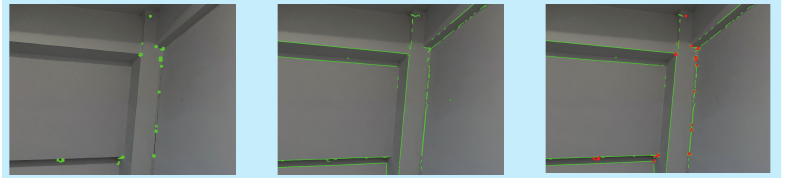
Figure 11. Comparison of point and line feature extraction in a weak texture environment. From left to right are ORB point feature extraction, LSD line feature extraction, and point-line combination feature